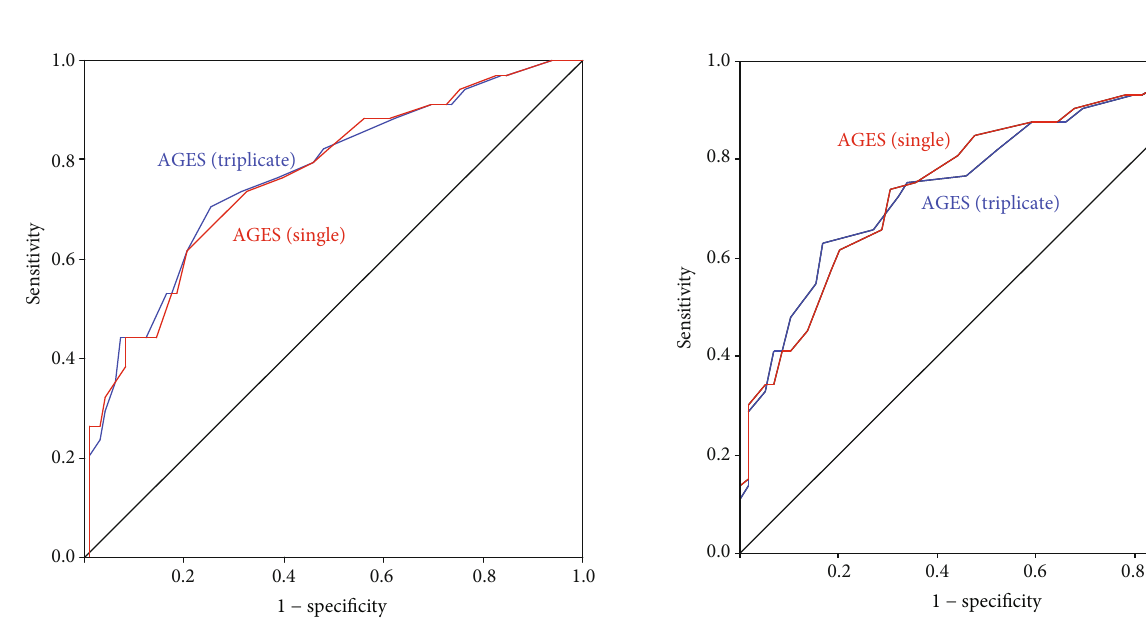
Figure 1: ROC analysis for the evaluation of the diagnostic signi fi cance of AGEs (single measurement) and AGEs (triplicate measurement) for large fi bre impairment.